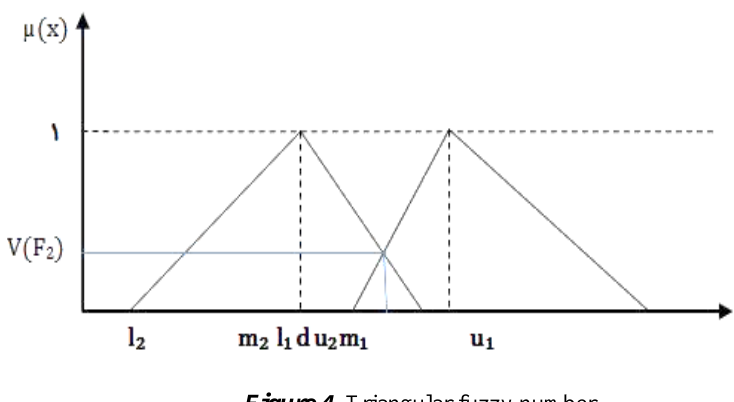
Figure 4. Triangular fuzzy